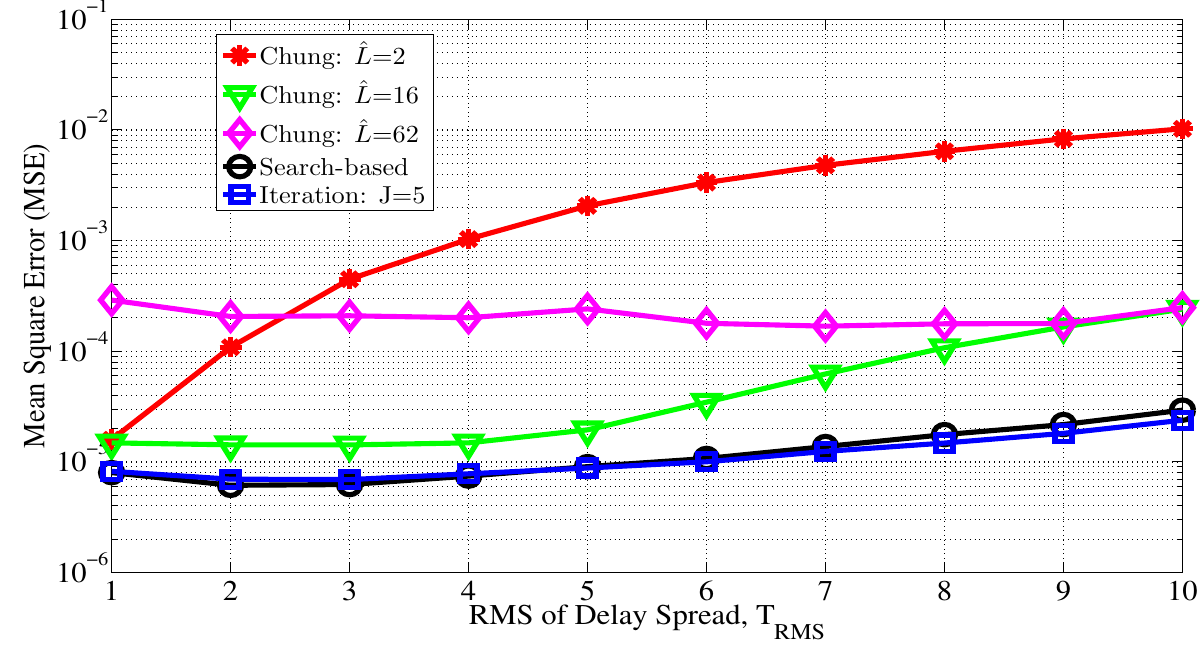
Figure 6. MSE performance of the proposed and Chung’s CFO estimators for different RMSs of channel delay spread, τ . N = 256, K = 64, SNR = 30 dB, (cid:15)